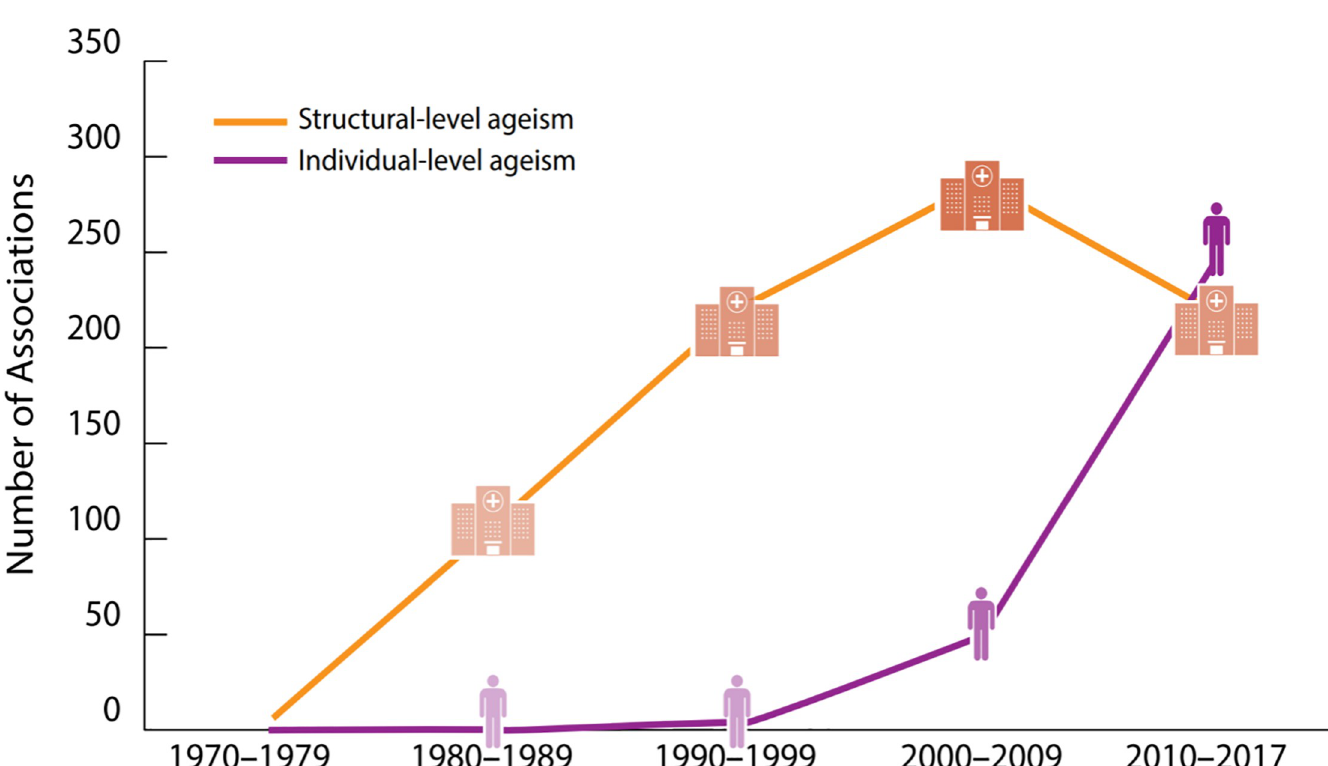
Fig 5. Research attention given to structural-level and individual-level ageism on health studies over time.